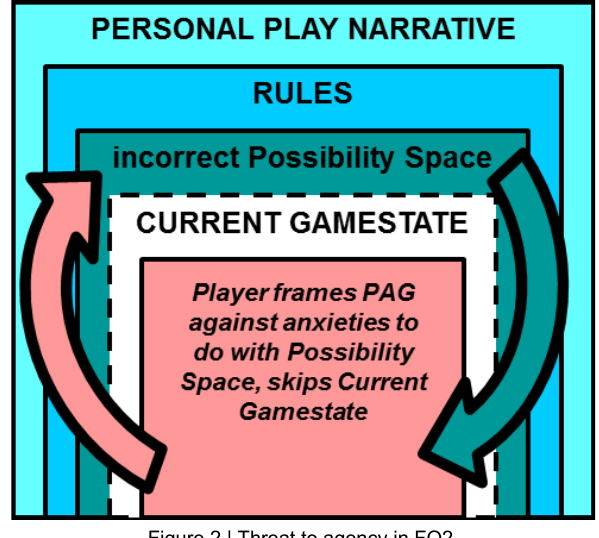
Figure 2 | Threat to agency in